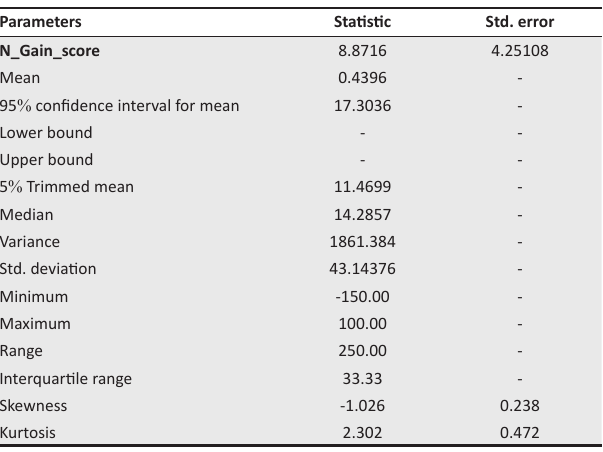
TABLE 4 : N-Gain score calculation. Parameters Statistic Std.